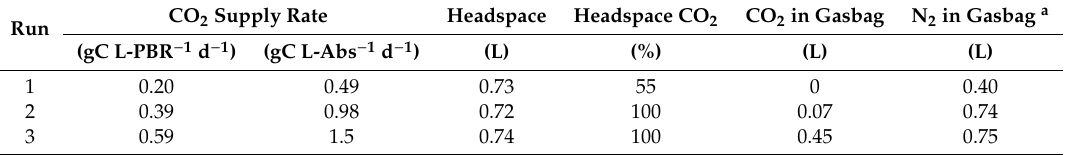
Table 1. Gas supply configuration for CO 2 absorption